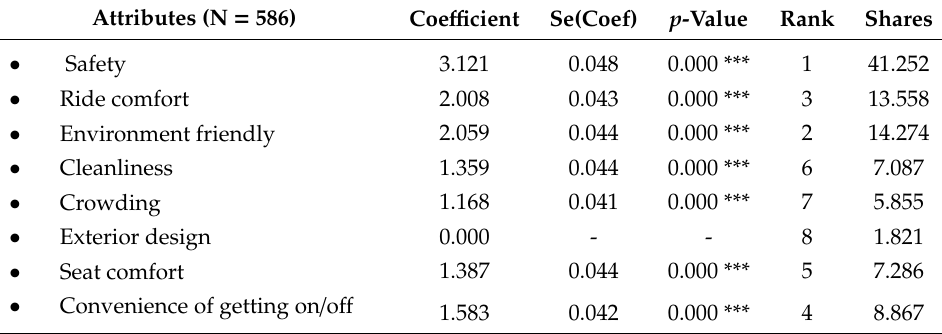
Table 6. Conditional logit model-based best-worst scaling scores (modeling